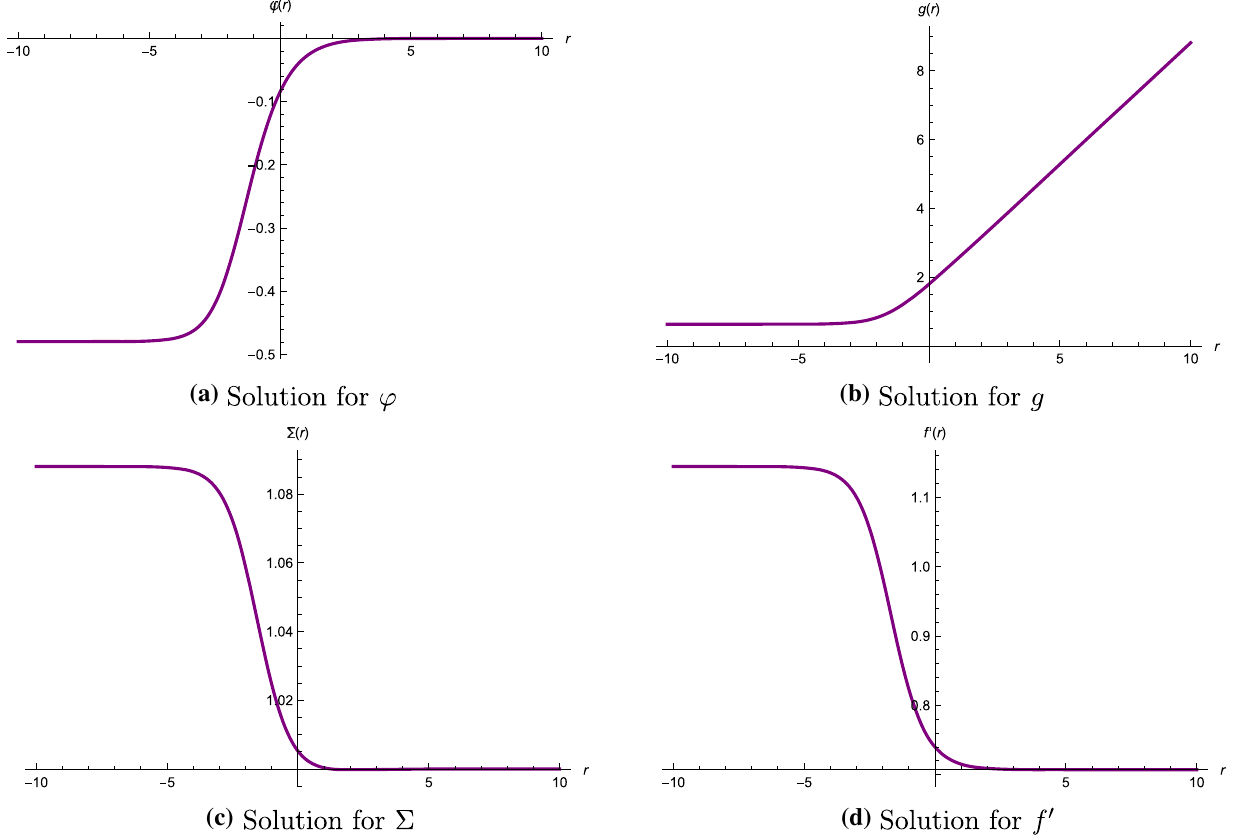
Fig. 2 An RG flow from N = 4 AdS 5 critical point with U ( 1 ) × SU ( 2 ) × SU ( 2 ) symmetry to N = 2 AdS 3 × S 2 geometry in the IR with U ( 1 ) × U ( 1 ) × U ( 1 ) symmetry and g 1 = 1, a 5 = 2 and a 8 = −